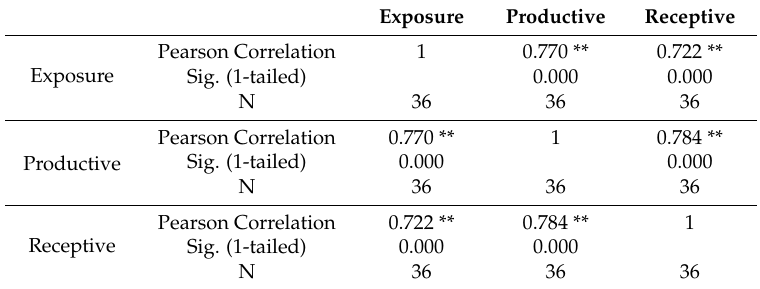
Table 6. Pearson Bivariate Correlation Test for the Relationship between Hours of Exposure to Informal, Naturalistic English and the Productive and Receptive Knowledge of